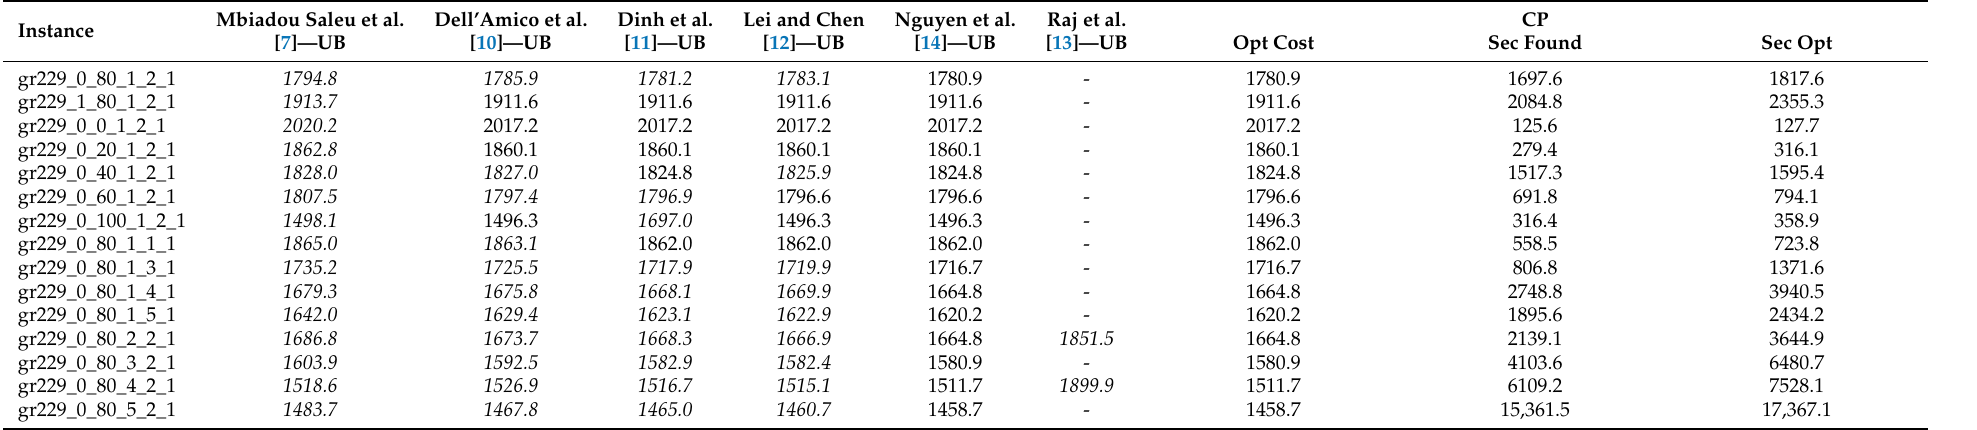
Table 7. Instances originated from gr229 in [7]. Optimal solution